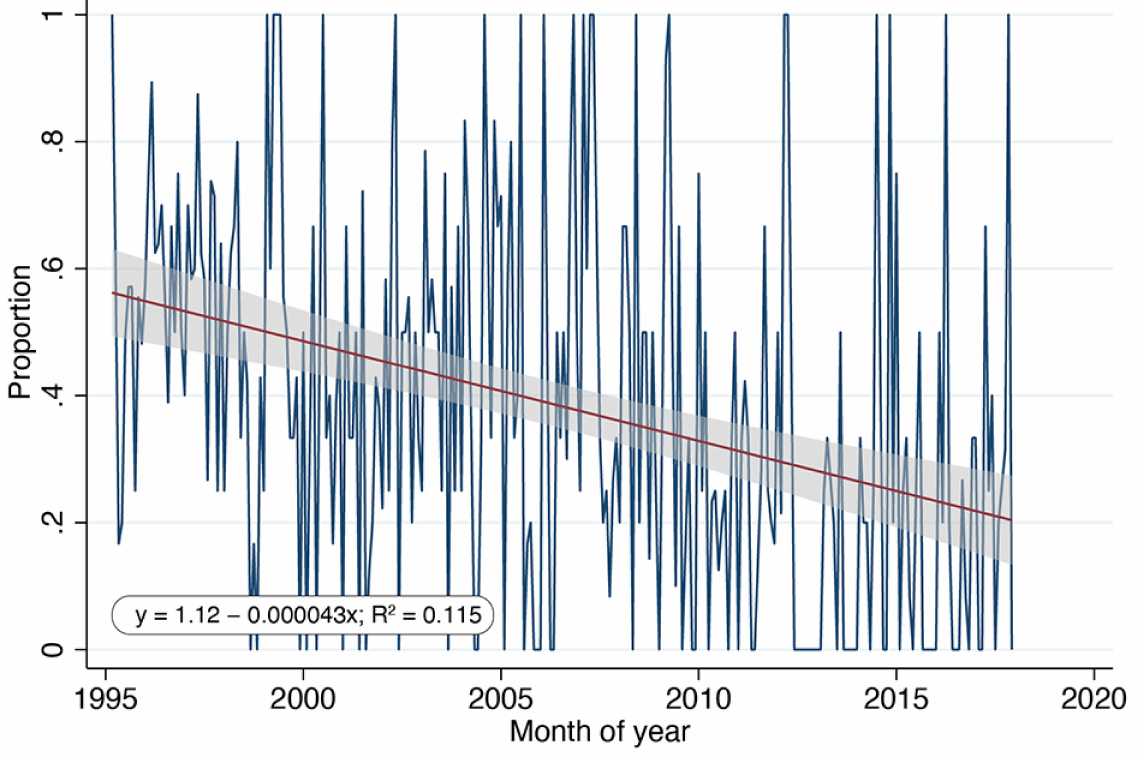
Figure 6. Proportion of female cats relative to all female cats, regardless of age, determined to be pregnant at time of surgery each month, ORCAT program (1995–2016). Comparable data from the UCF program were